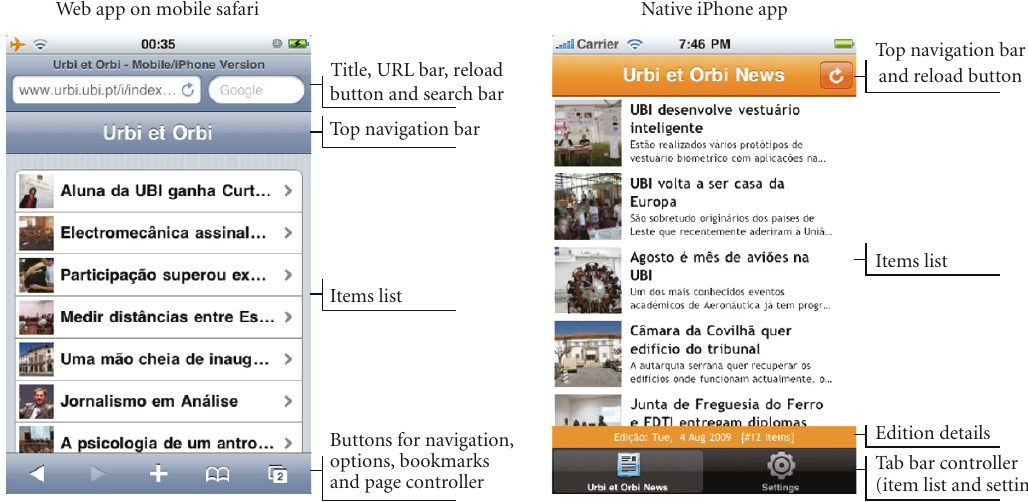
Figure 3: Web versus native applications di ff erences and